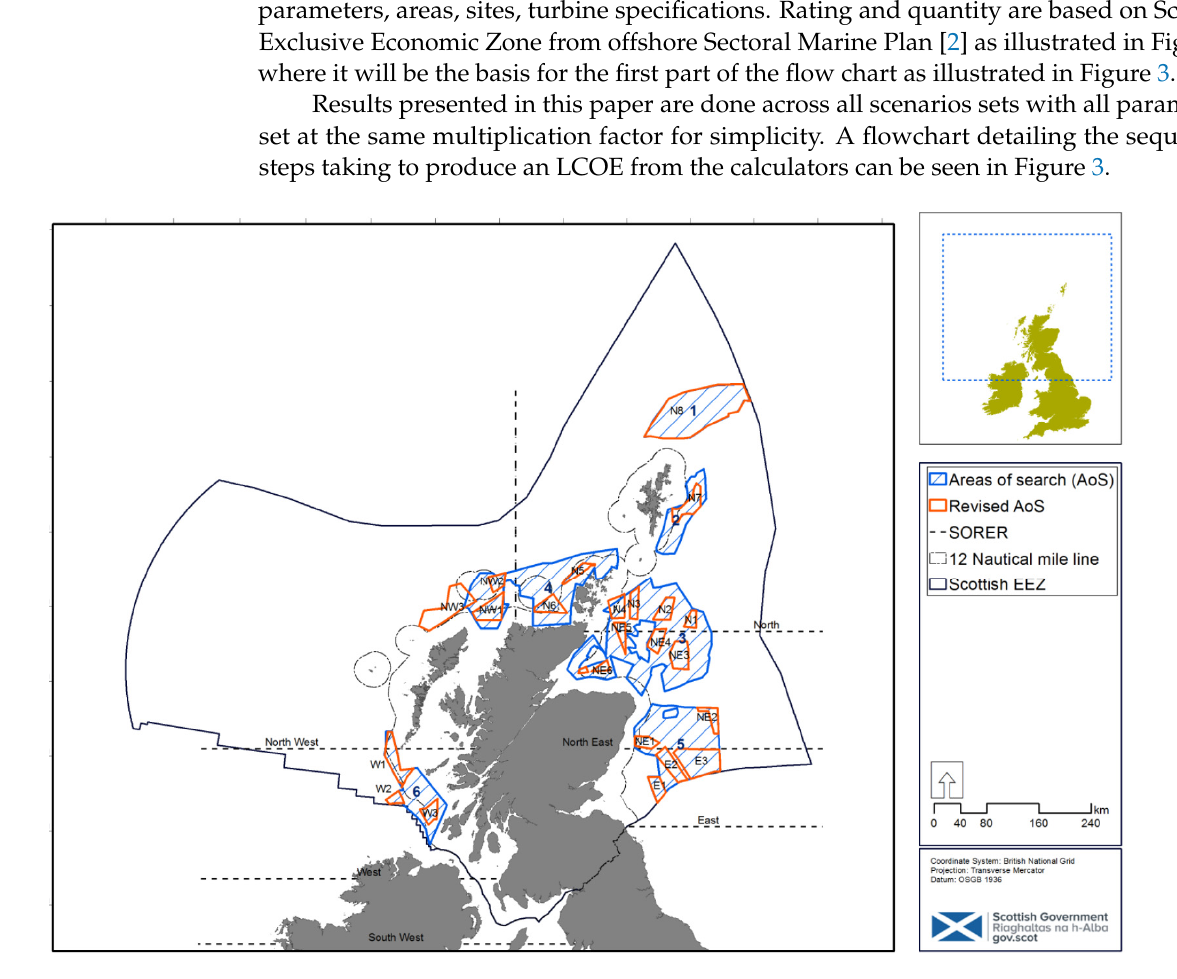
Figure 2. Wind Development Sites